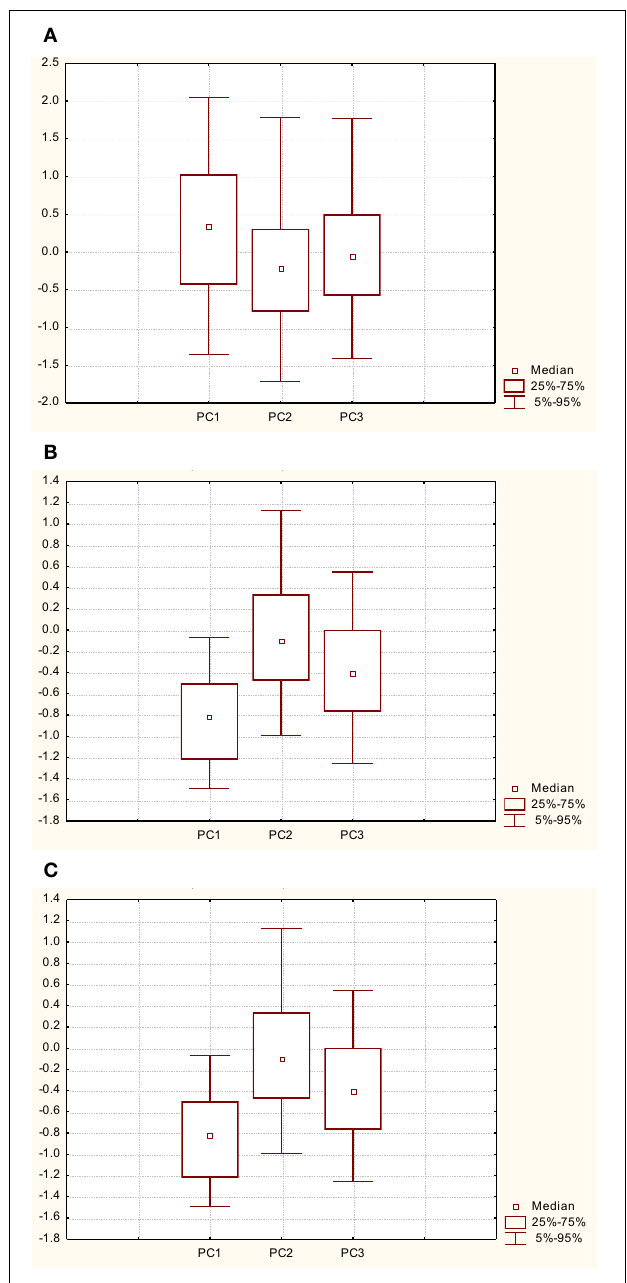
FIGURE 3 | The percentage of recognized temperature (A) and wind speed (B) events relative to the theoretically maximum number of